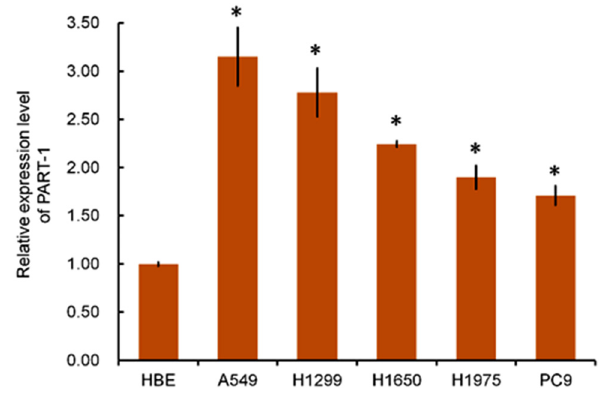
Figure 1: The expression of PART-1 in the HBE cell line and NSCLC cell lines, including A549, H1229, H1650, H1975, and PC9, as assayed by quantitative RT ‒ PCR. The expression level of the PART-1 gene increased signi fi cantly in NSCLC cell lines. *Indicates